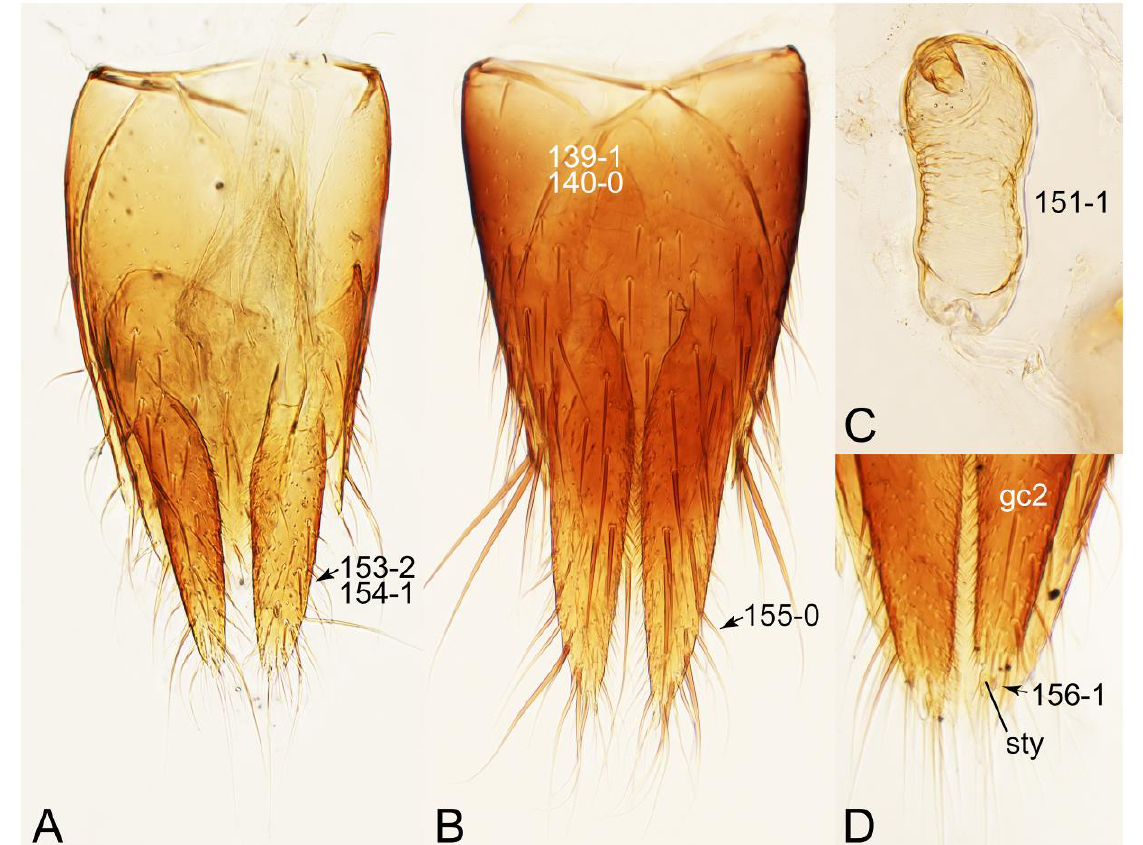
Figure 73. Photographs of body parts of Mycetoporinae, female genital segments and genitalia, enlarged. ( A ) genital segments of Bryophacis smetanai , ventral view. ( B ) genital segments of Ischnosoma splendidum , dorsal view. ( C ) spermatheca of Bryoporus cf. orientalis . ( D ) gonocoxite II and gonostylus of Neobolitobius varians , ventral view. Abbreviations: gc2, gonocoxite II; sty, gonostylus. Characters and character states (format X-X) are indicated on each